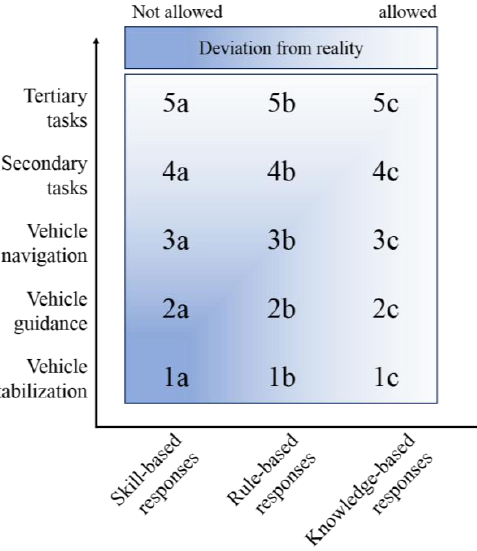
Figure 2. Scheme for classifying driving simulator applications. Reproduced with permission from [6], Technical University of Munich, Munich, Germany, 2007.